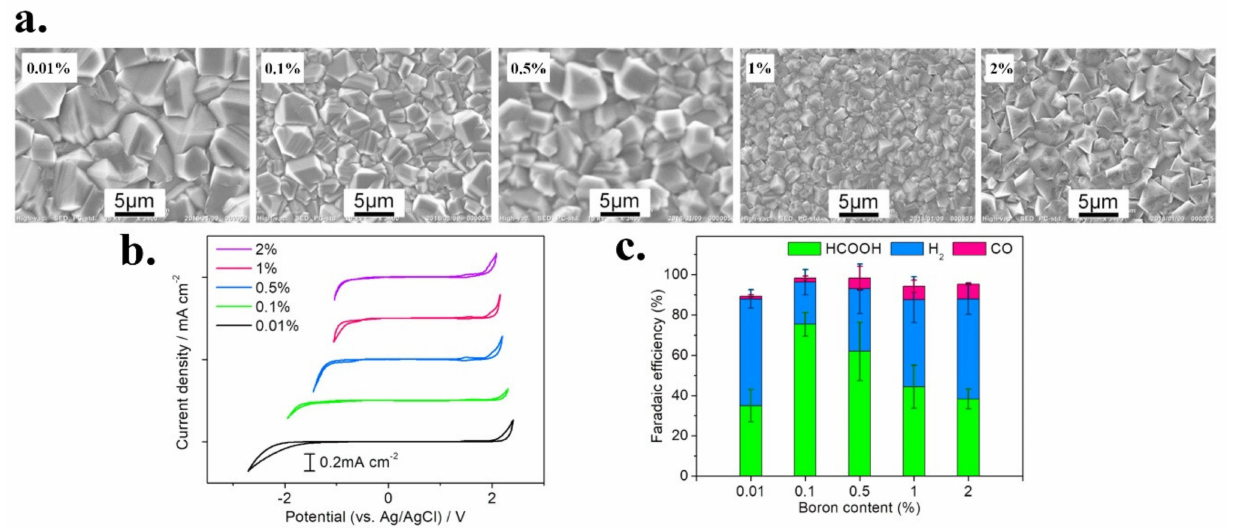
Figure 9. ( a ) SEM images of Boron-doped diamond (BDD) electrodes with different boron content. ( b ) Cyclic voltammetry (CV) curves of BDD electrodes in 0.1 M H 2 SO 4 at a scan rate of 0.1 V s − 1 , ( c ) Faradaic efficiencies to formic acid. Adapted from